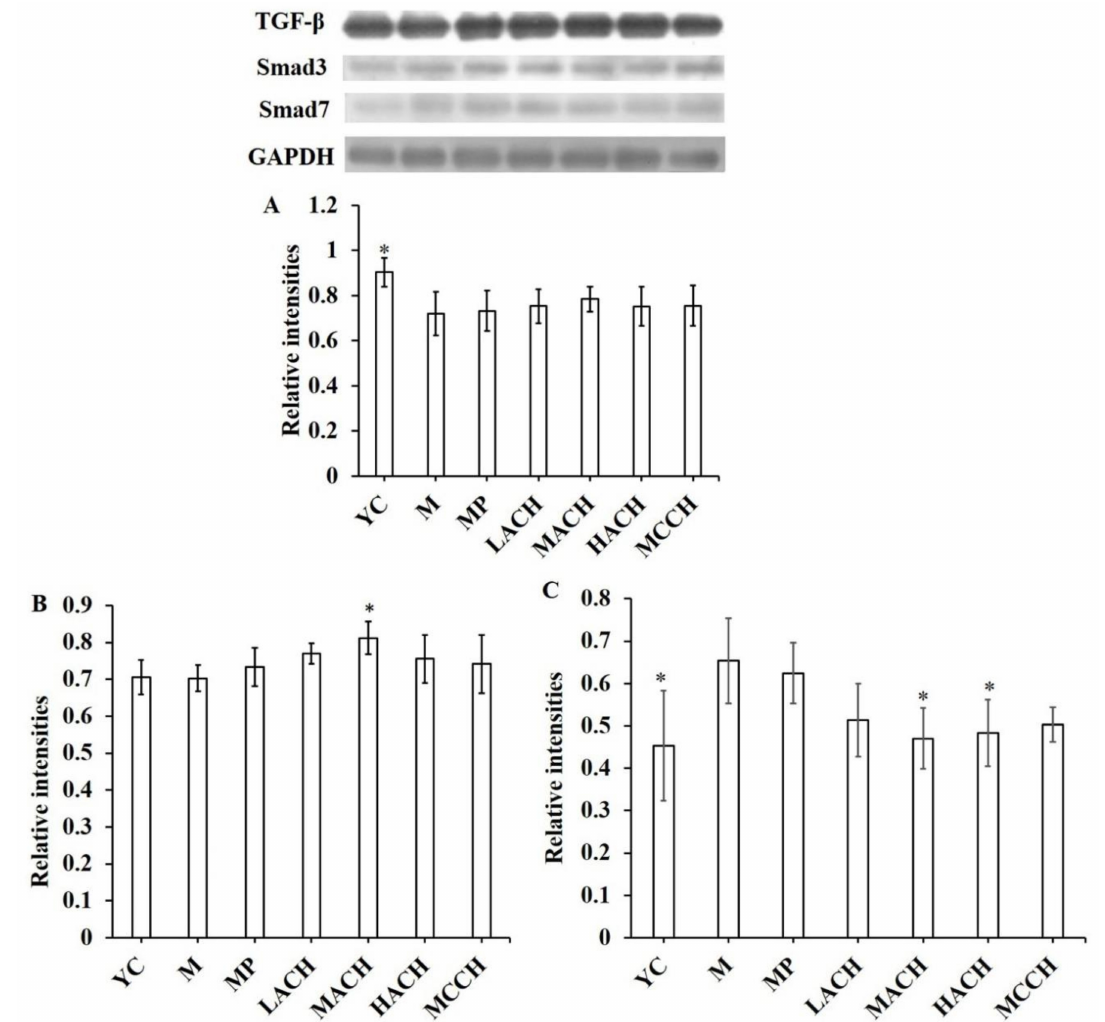
Figure 3. Effect of collagen hydrolysates on the transforming growth factor β (TGF- β )/Smad signaling pathway in chronologically aged mice. GAPDH, glyceraldehyde-3-phosphate dehydrogenase. ( A ) TGF- β ; ( B ) Smad3; ( C ) Smad7. YC, young control group; M, model group; MP, medium dose of proline; LACH, MACH and HACH represent the low, medium and high dose of ACH, respectively; MCCH, medium dose of CCH. * means a significant difference was observed compared to M group ( p <